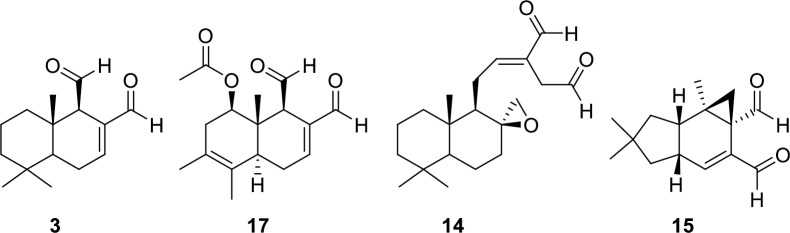
Chemical structures of α,ß-unsaturated 1,4-dialdehydes.Polygodial (3), 1ß-acetoxy-9-deoxy-isomuzigadial (17), miogadial (14), (+)-isovelleral (15).